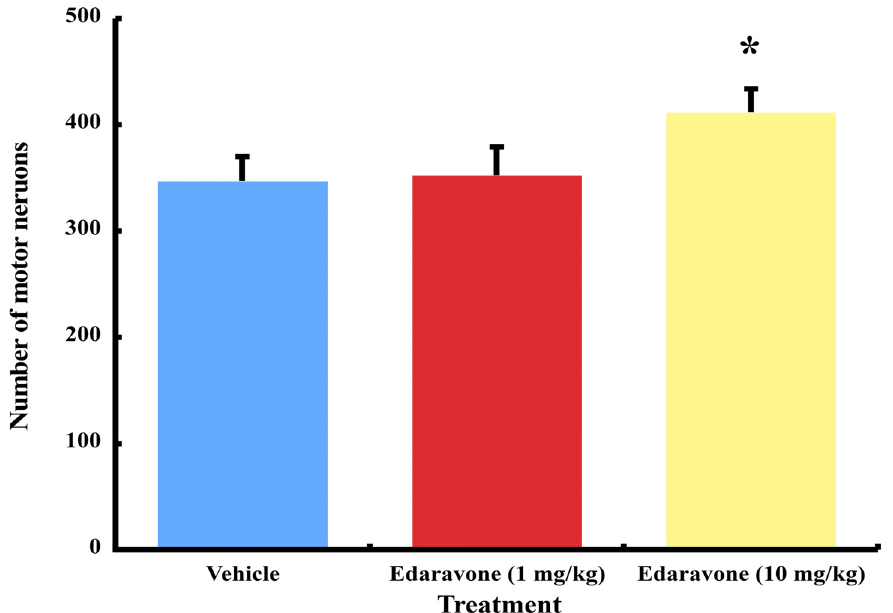
Fig 3. The number of spinal motor neurons in edaravone- and vehicle-treated wobbler mice. Mice treated with higher dose of edaravone increased the number of motor neurons significantly compared to vehicle. * P < 0.05, the higher dose of edaravone group versus the vehicle group by one-way ANOVA and Dunnett multiple comparison test. Results are represented as the mean ± SEM (n = 10/group).